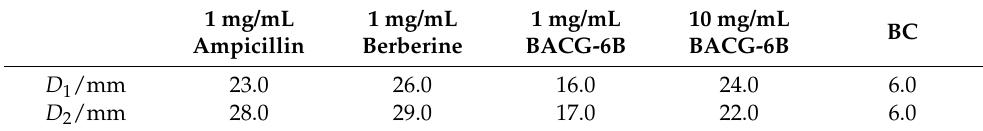
Table 2. Bacteriostatic